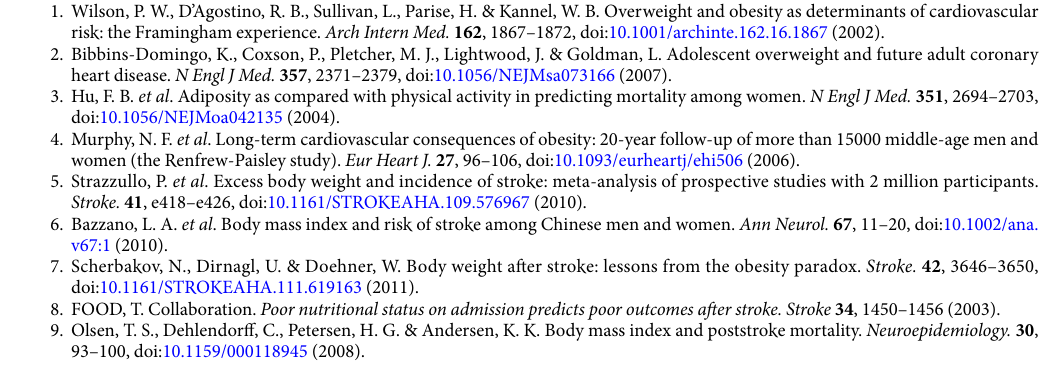
6 Scientific RepoRts | 7: 2507 | DOI:10.1038/s41598-017-02551-0